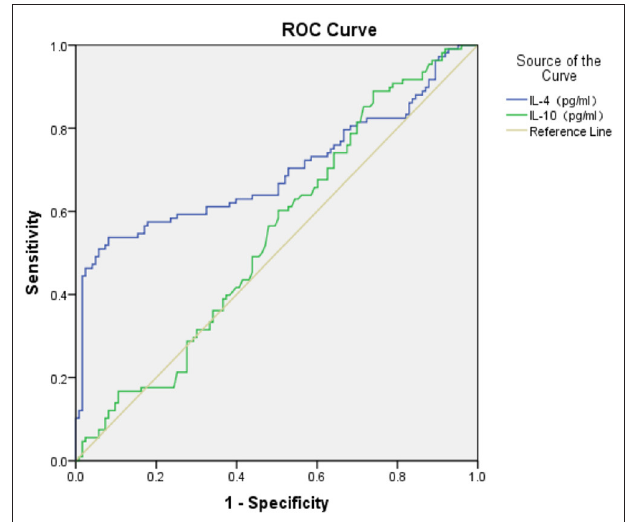
FIGURE 2 | ROC of IL-4, IL-10 in diagnosis of